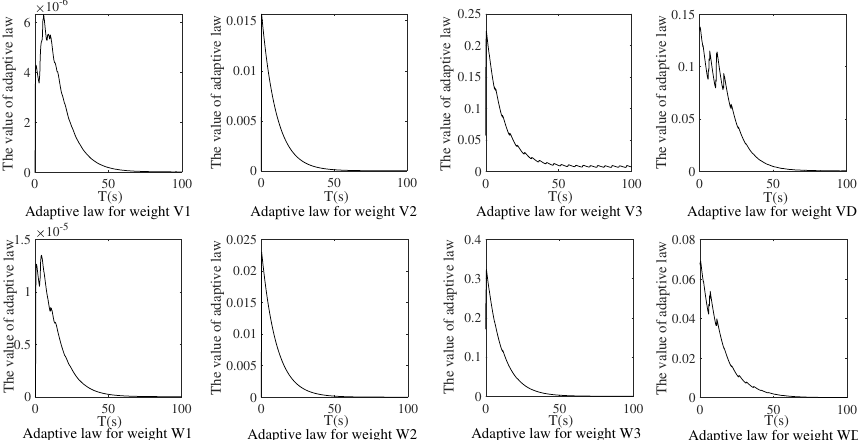
Figure 5. Adaptive compensation laws in known time-varying delay form (with dead-zone compen- sation controller).